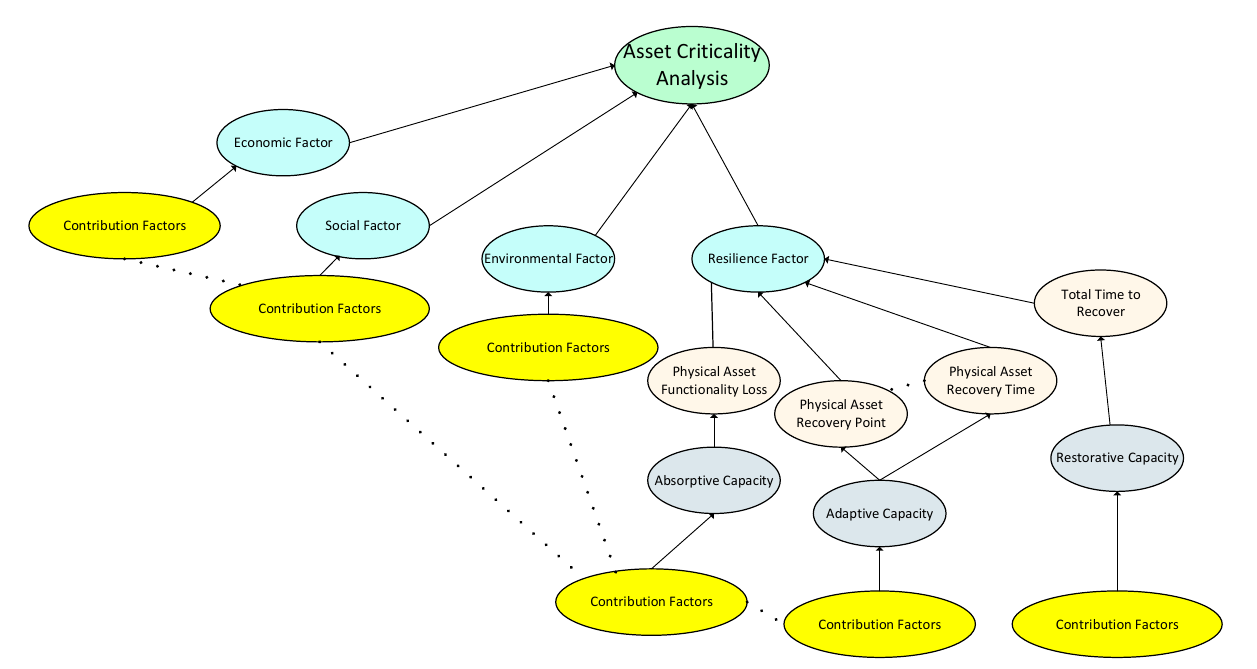
Figure 3. General BN structure for physical asset criticality analysis .